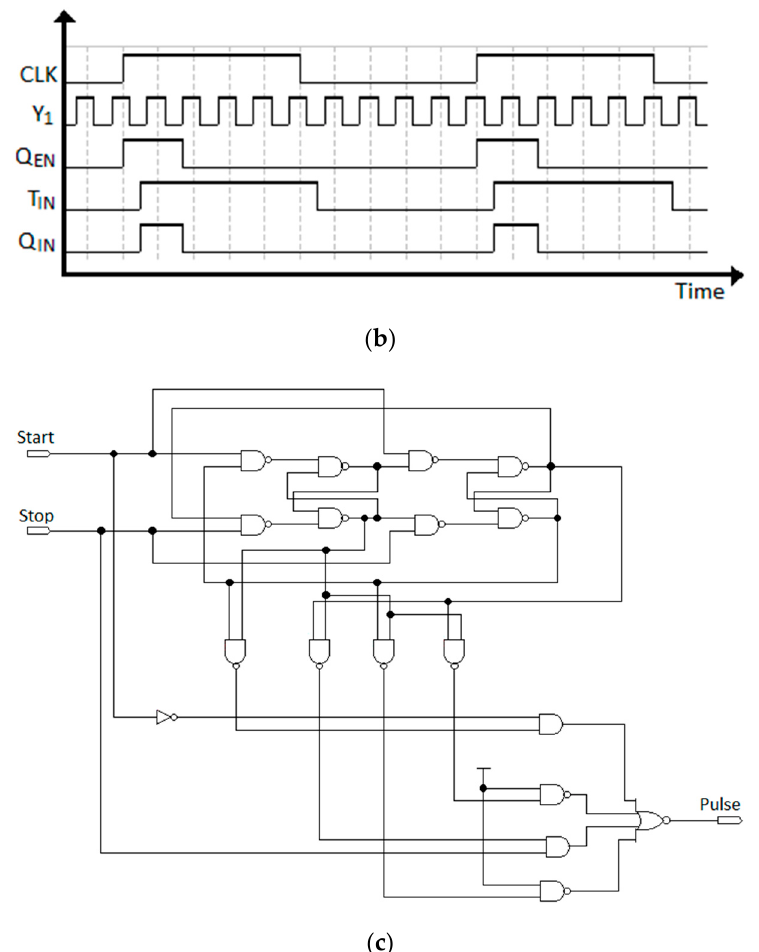
Figure 8. Interstage synchronizer (IntS Sync): ( a ) block diagram; ( b ) timing diagram; ( c ) schematic of the edge-sensitive pulse generator (ESPG).